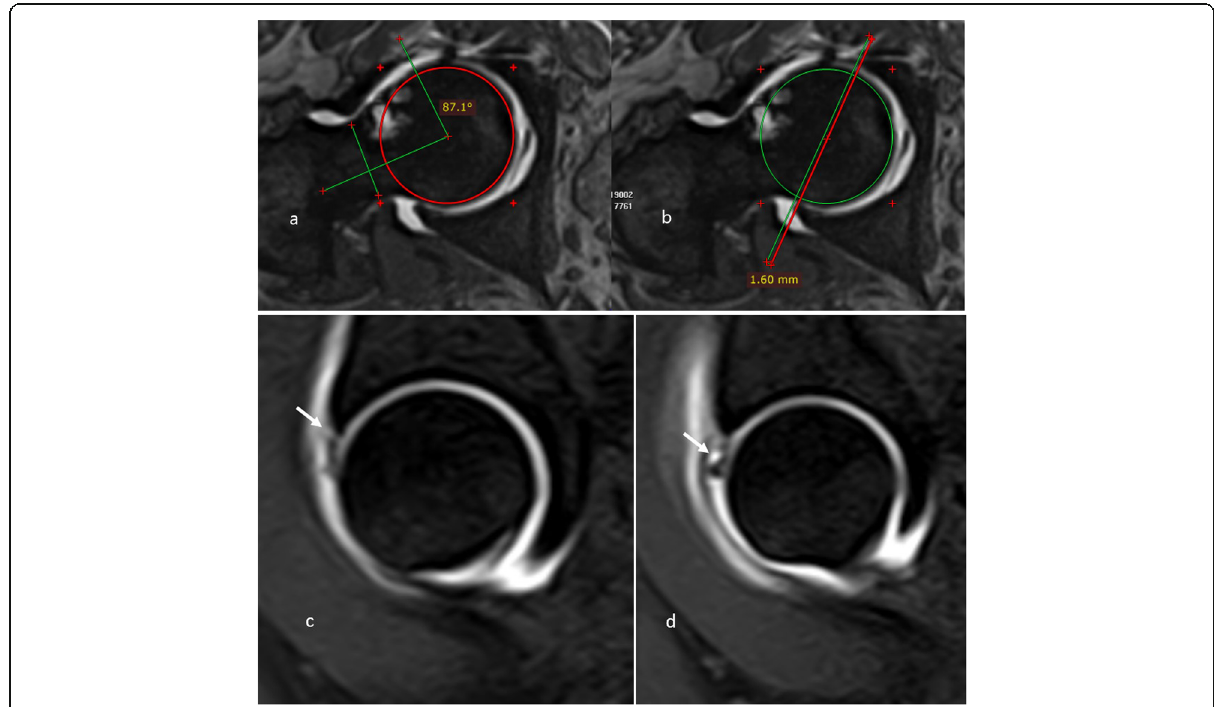
Fig. 5 Femoroacetabular impingement (mixed type) in a 40-year-old female, complaining of right hip pain and limitation of movement. a , b Axial oblique T1 fat sat post-contrast: a increased alpha angle (87.1°), with the loss of the normal head – neck waist being slightly convex and showing multiple cysts, b deep acetabulum ( − 1.6 mm). c, d Sagittal T1 fat sat post-contrast: c anterior labral complete tear detected as high signal contrast extending across the labrum edge to base and disrupting its acetabular attachment (arrow in c ) and associated tiny paralabral cyst (arrow in d